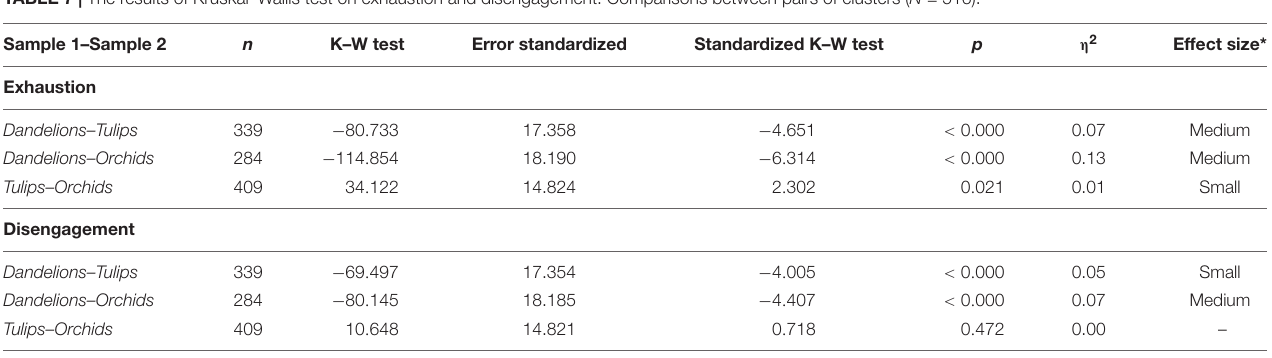
FIGURE 3 | Mean scores on burnout symptoms in clusters of low ( Dandelions ), medium ( Tulips ), and high ( Orchids ) sensitivity: (A) Exhaustion ; (B) Disengagement . TABLE 7 | The results of Kruskal–Wallis test on exhaustion and disengagement: Comparisons between pairs of clusters ( N =